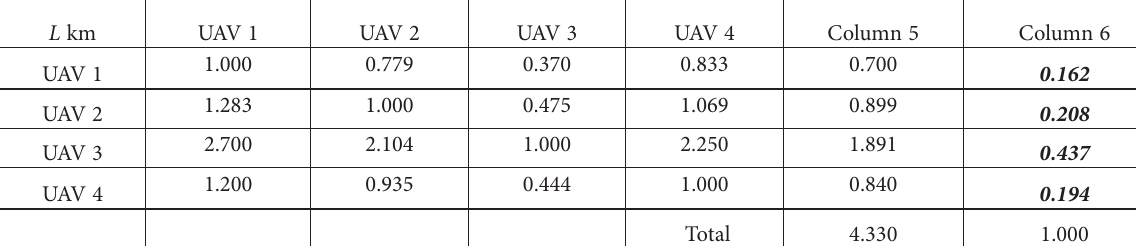
Table 6. Range matrix L km